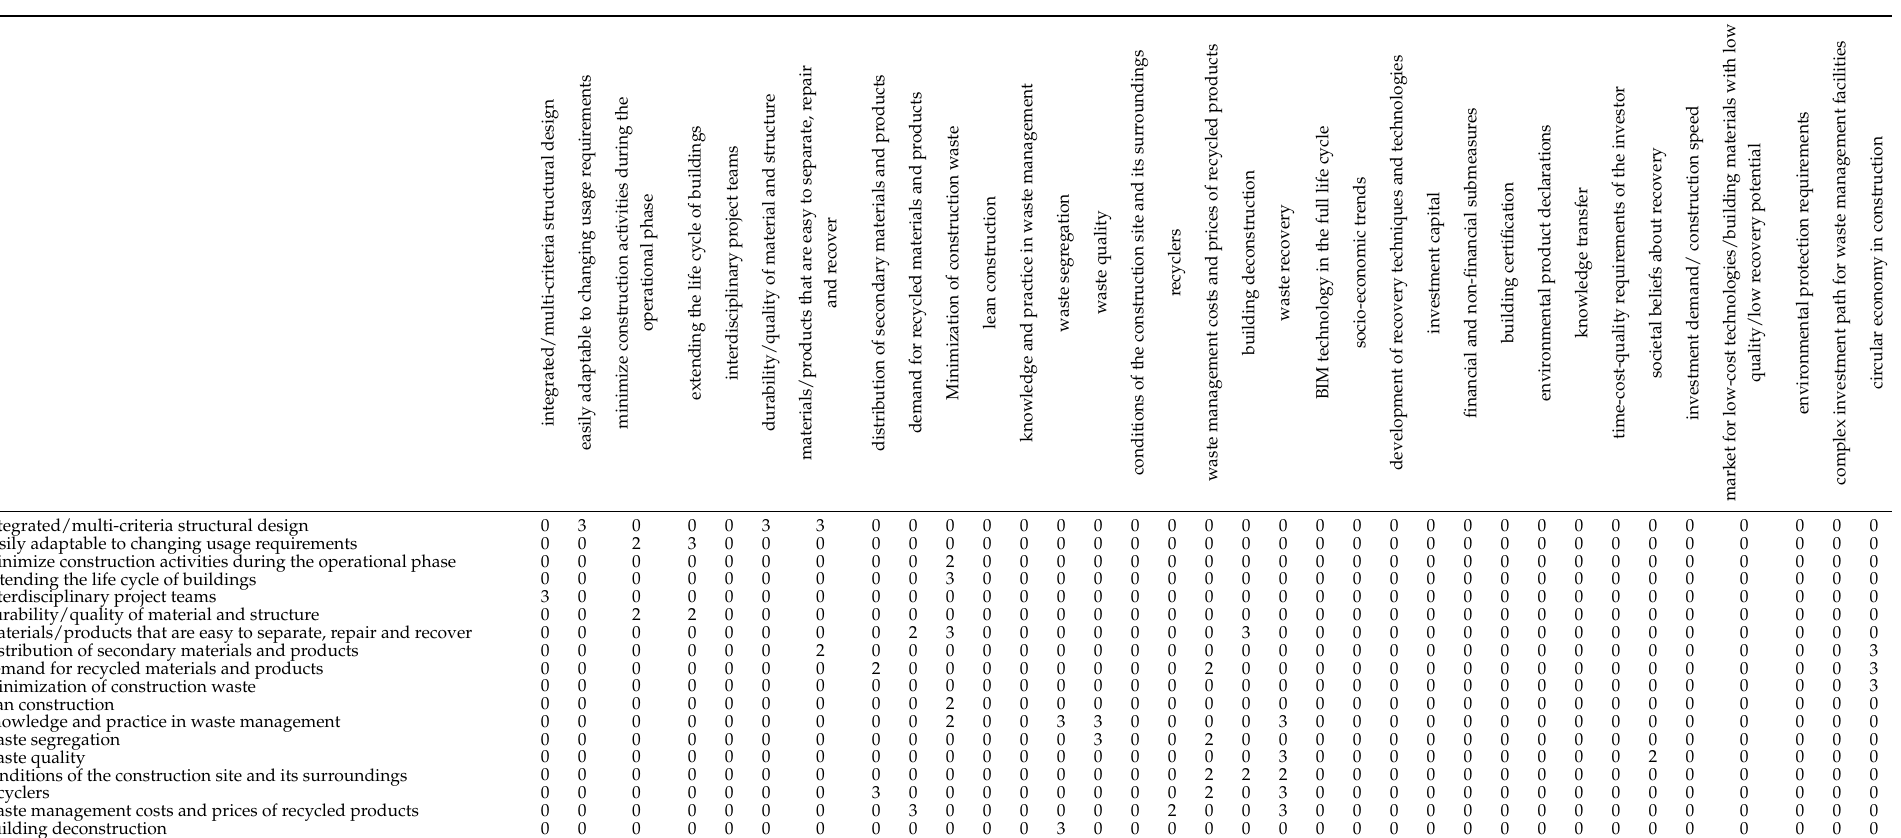
Table A1. Direct influence